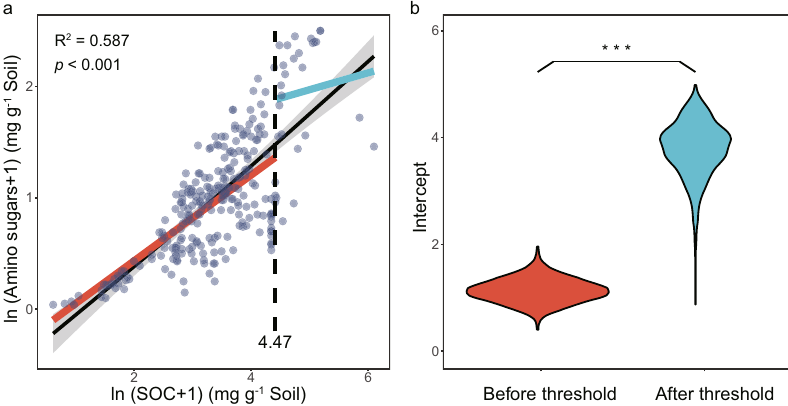
Fig. 4 Models of amino sugars responding to soil organic carbon (SOC). a Nonlinear responses of amino sugars to SOC. b Differences of predicted values of variables under SOC threshold. The data are logarithmically transformed; details are as described in the Fig. 3